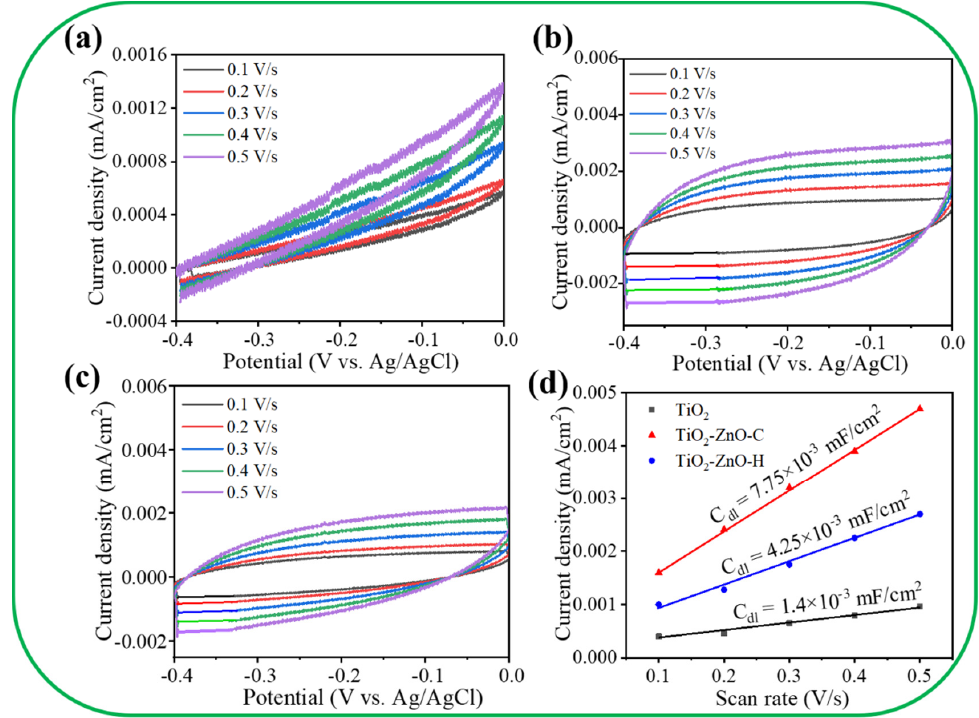
Figure 7. The current density vs. potential plots at various scan rates: ( a ) TiO 2 . ( b ) TiO 2 –ZnO–C. ( c ) TiO 2 –ZnO–H. ( d ) Current density vs. scan rate plot of various samples.